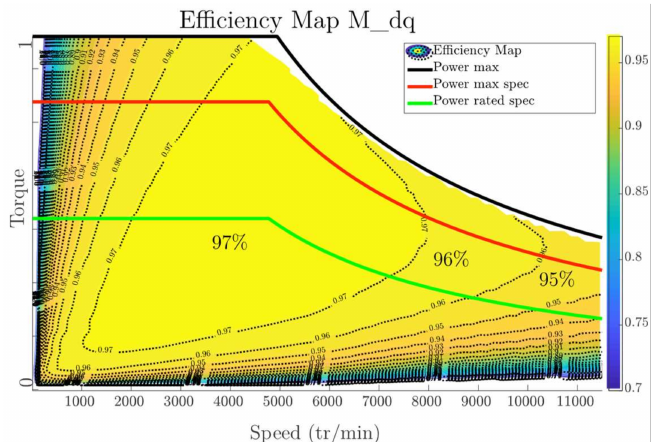
Figure 20. Efficiency map for the machine optimized by the “dq